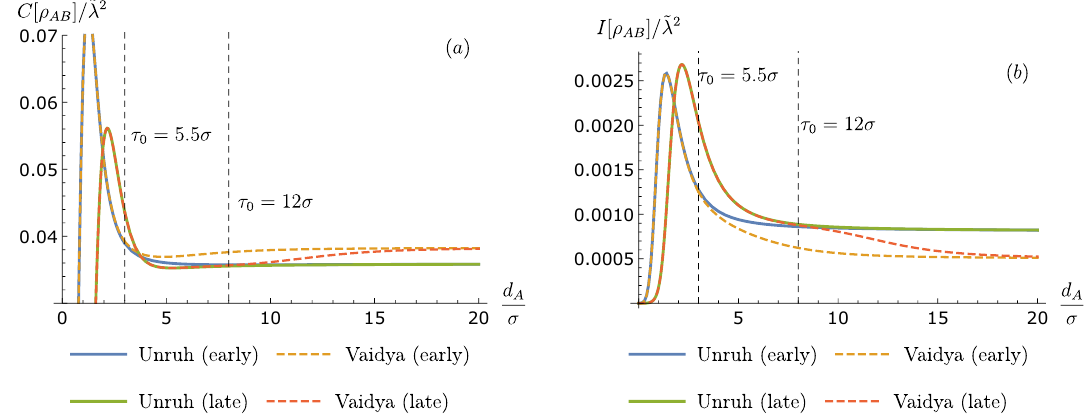
Figure 9 . Comparison of (a) concurrence and (b) mutual information for Unruh and Vaidya vacua when the switching function is peaked at (cid:28) 0 = 5 : 5 (cid:27) (early) and (cid:28) 0 = 12 (cid:27) (late). Here ~ (cid:21) = (cid:21)(cid:27) 1 (cid:0) n 2 = (cid:21) is dimensionless coupling constant. We set (cid:10) (cid:27) = 2, M(cid:27) = 1 and d ( r A ; r B ) = 3 (cid:27) . The ‘bifurcation 2 point’ at which the two states begin to show di(cid:11)erences in concurrence is now at about d A (cid:25) 3 (cid:27) when (cid:28) 0 = 5 : 5 (cid:27) , as compared to d A (cid:25) 8 (cid:27) when (cid:28) 0 = 12 (cid:27) , indicated by the vertical dashed